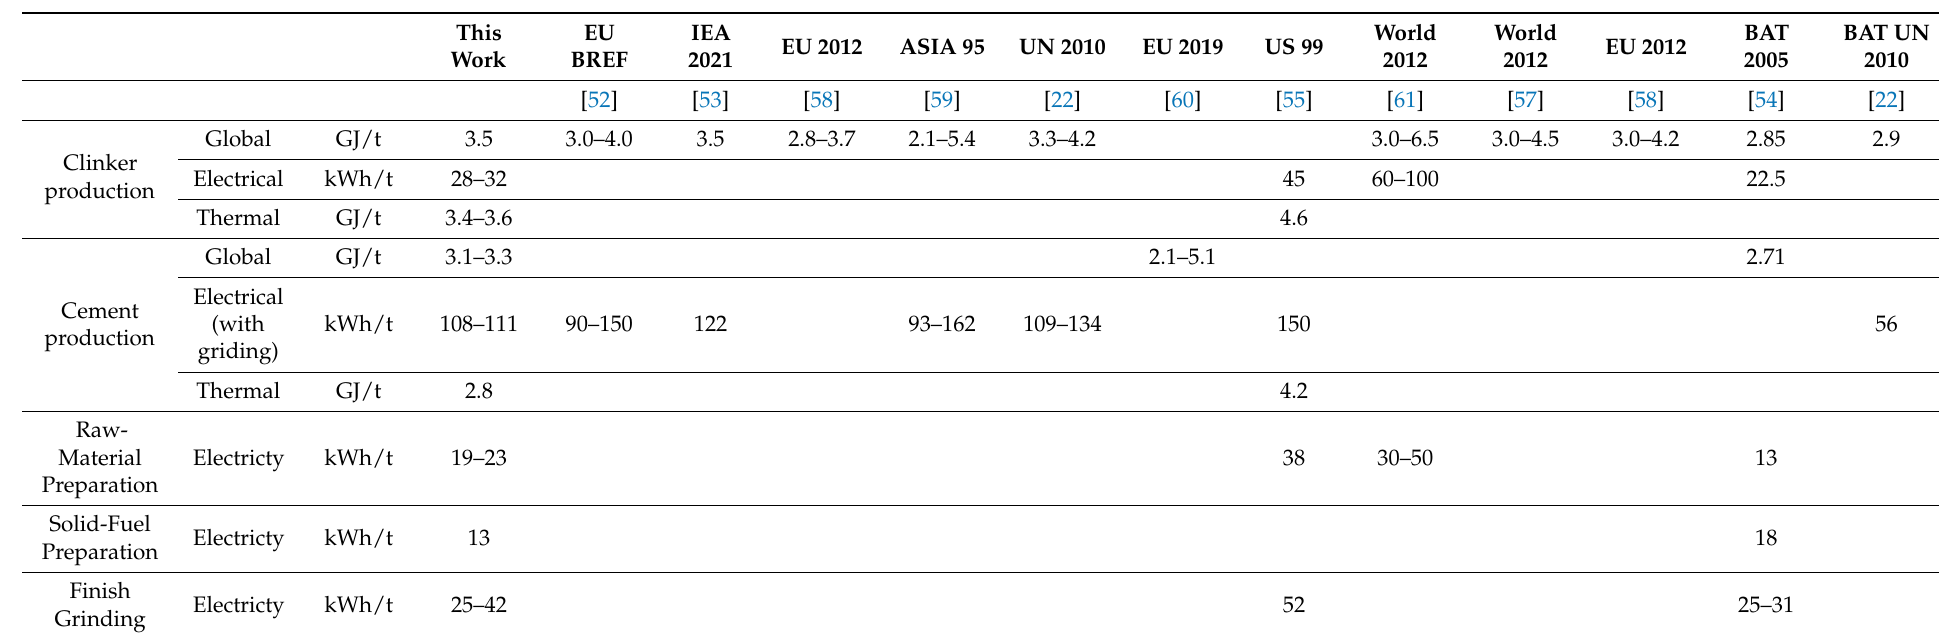
Table 6. Validation data of calculated EnPI for the cement